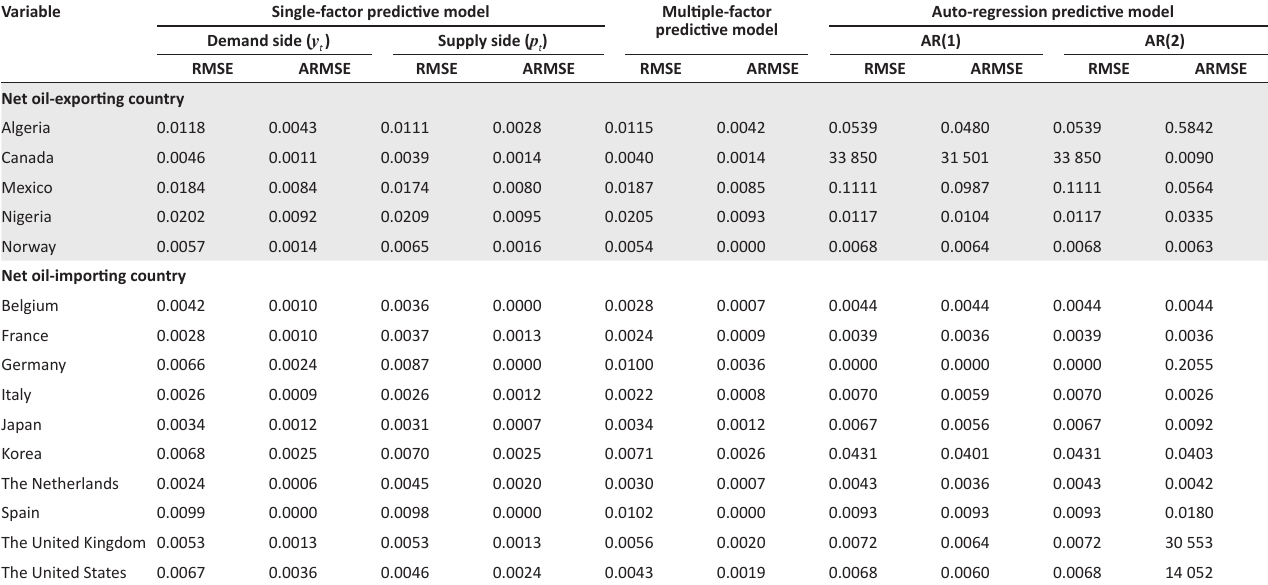
RMSE, root mean square error; ARMSE, adjusted root mean square error,; k , k th period ahead; AR,